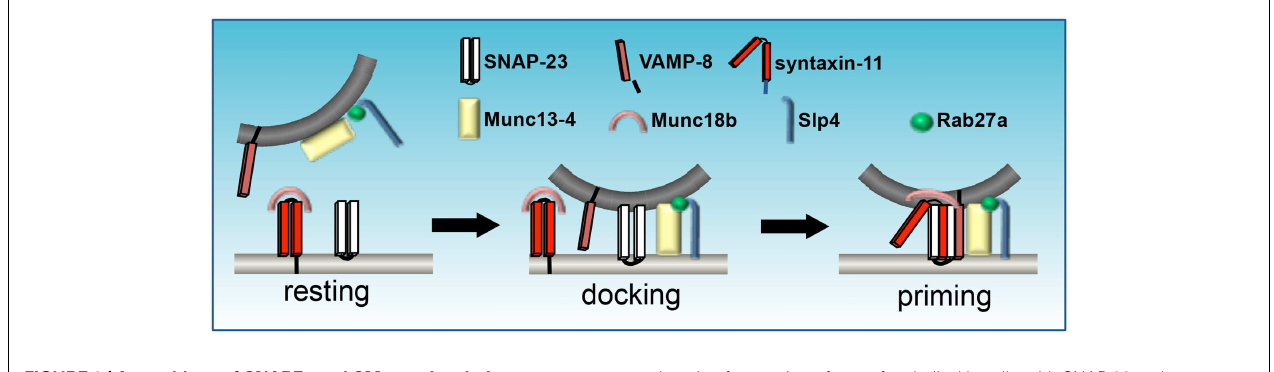
FIGURE 3 |Assemblage of SNAREs and SM proteins during platelet granule exocytosis . Munc18b sequesters syntaxin in an inactive state. Munc13-4 docks opposing membranes via interactions with Rab27a, which also binds Slp1. Activation promotes a conformational change in Munc18b that enables the coiled-coil